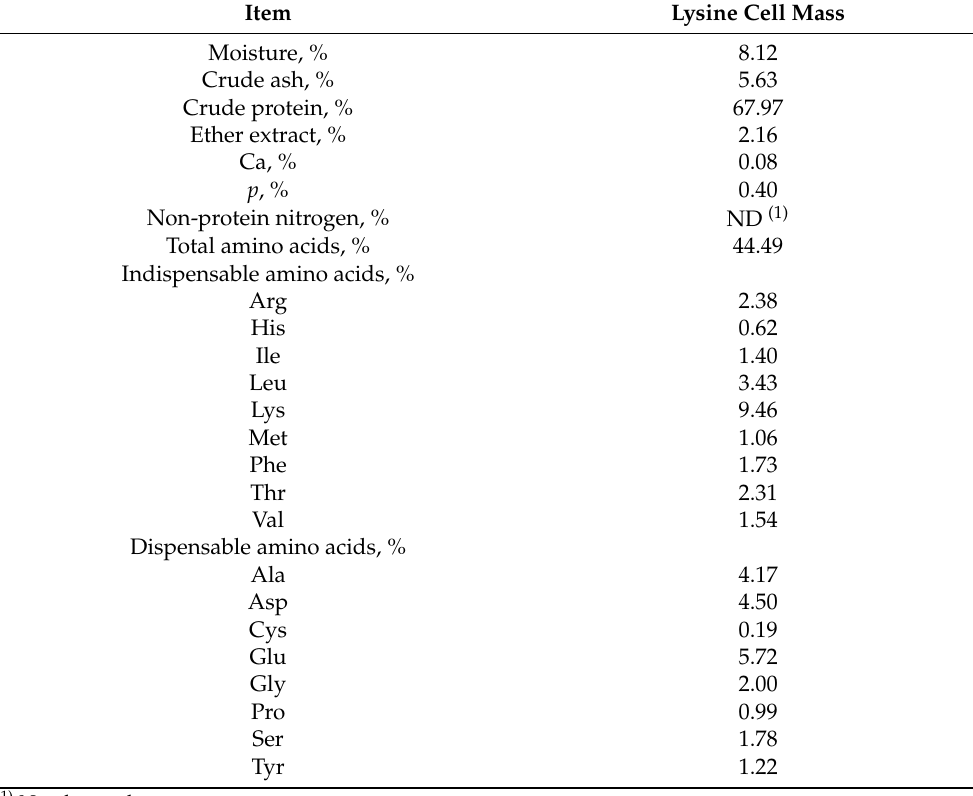
Table 1. Analyzed nutrient contents of lysine cell mass (as-is